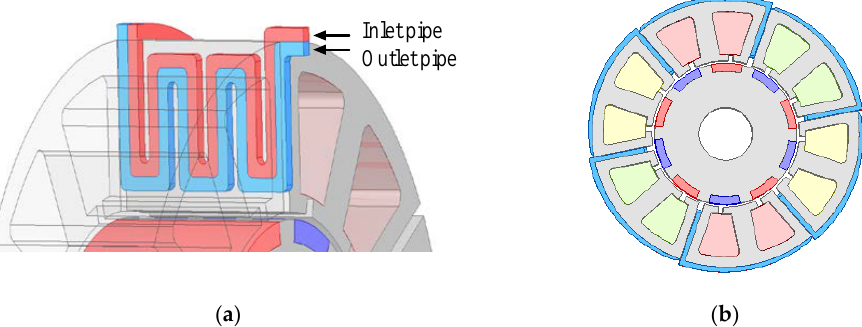
Figure 2. ( a ) Axial cooling using the stator gaps. ( b ) Radial cooling using the stator gaps.